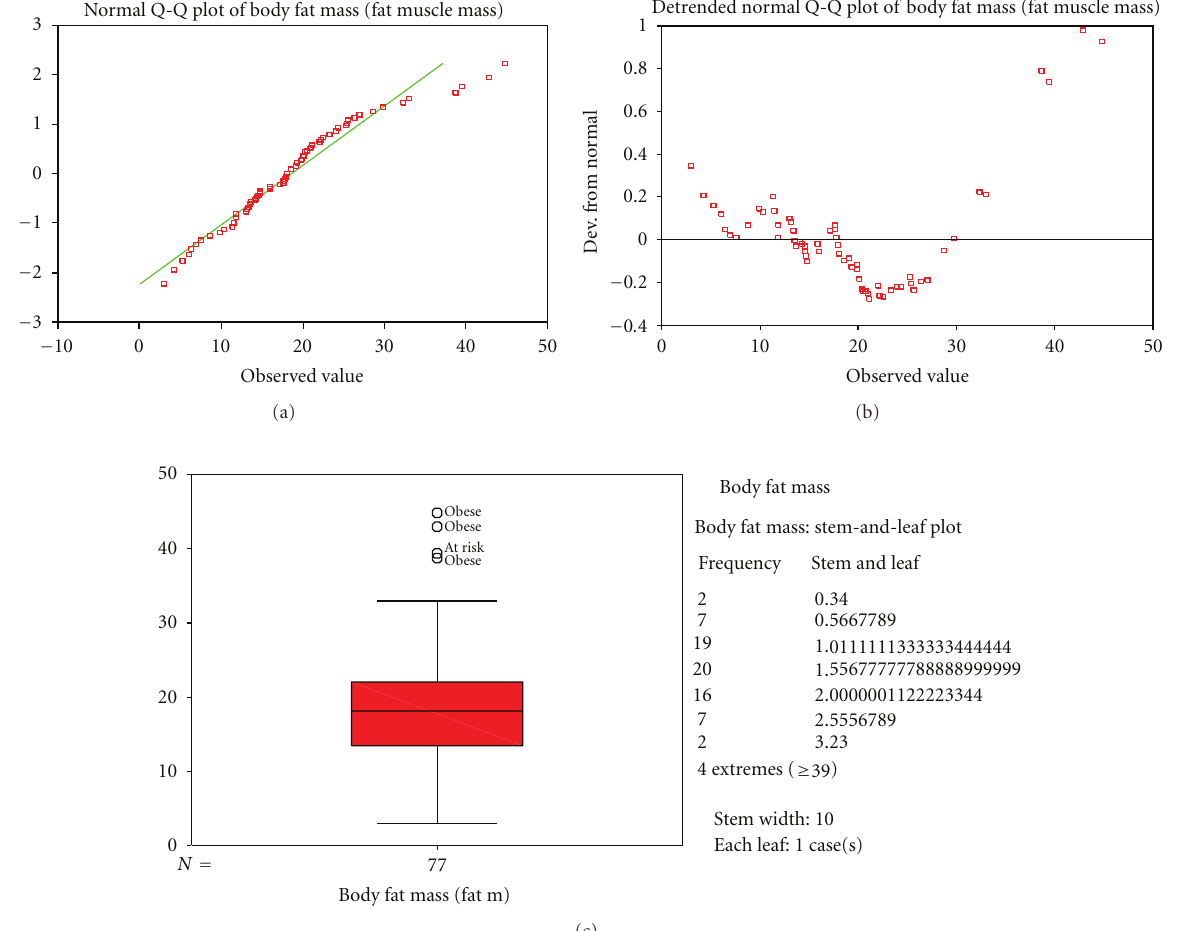
Figure 5: (a) Normal Q-Q plot of BFM, (b) detrended normal Q-Q plot of BFM, and (c) stem-leaf plot of BFM.